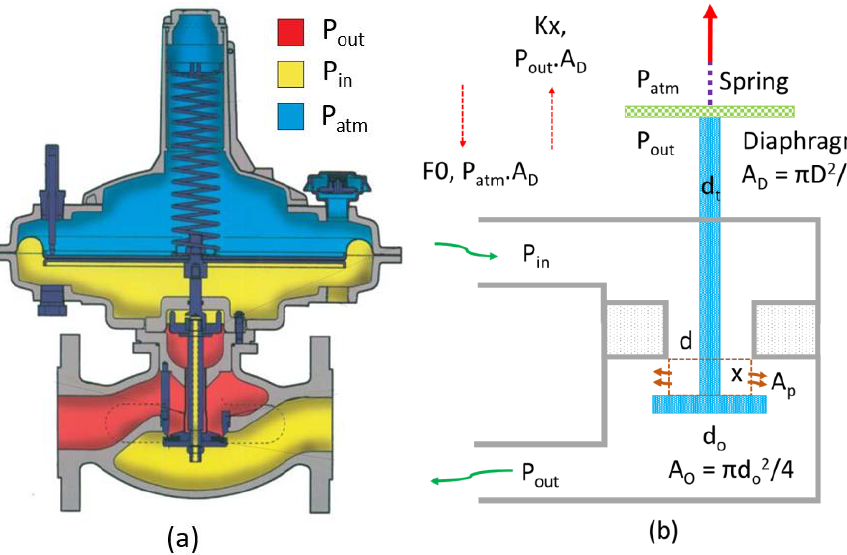
Figure 2. ( a ) A simple schematic of the HON 280 gas PR and ( b ) the force balance on the diaphragm and valve seat assemblies.